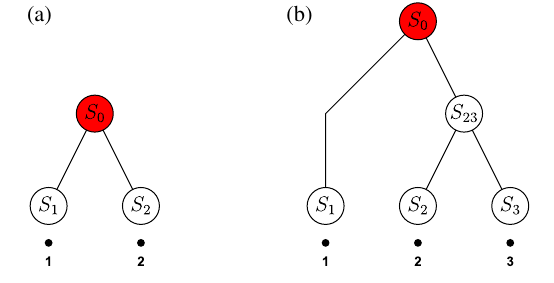
FIG. 19. SDRG trees representing states for a system of two (a) and three (b) spins. Explicit wave functions corresponding to these trees are give by Eqs. (A17) and